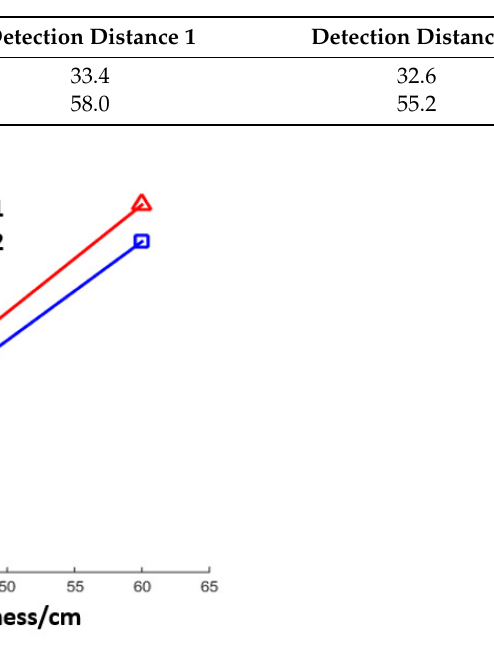
Table 7. Discrimination interaction experiment data 3.